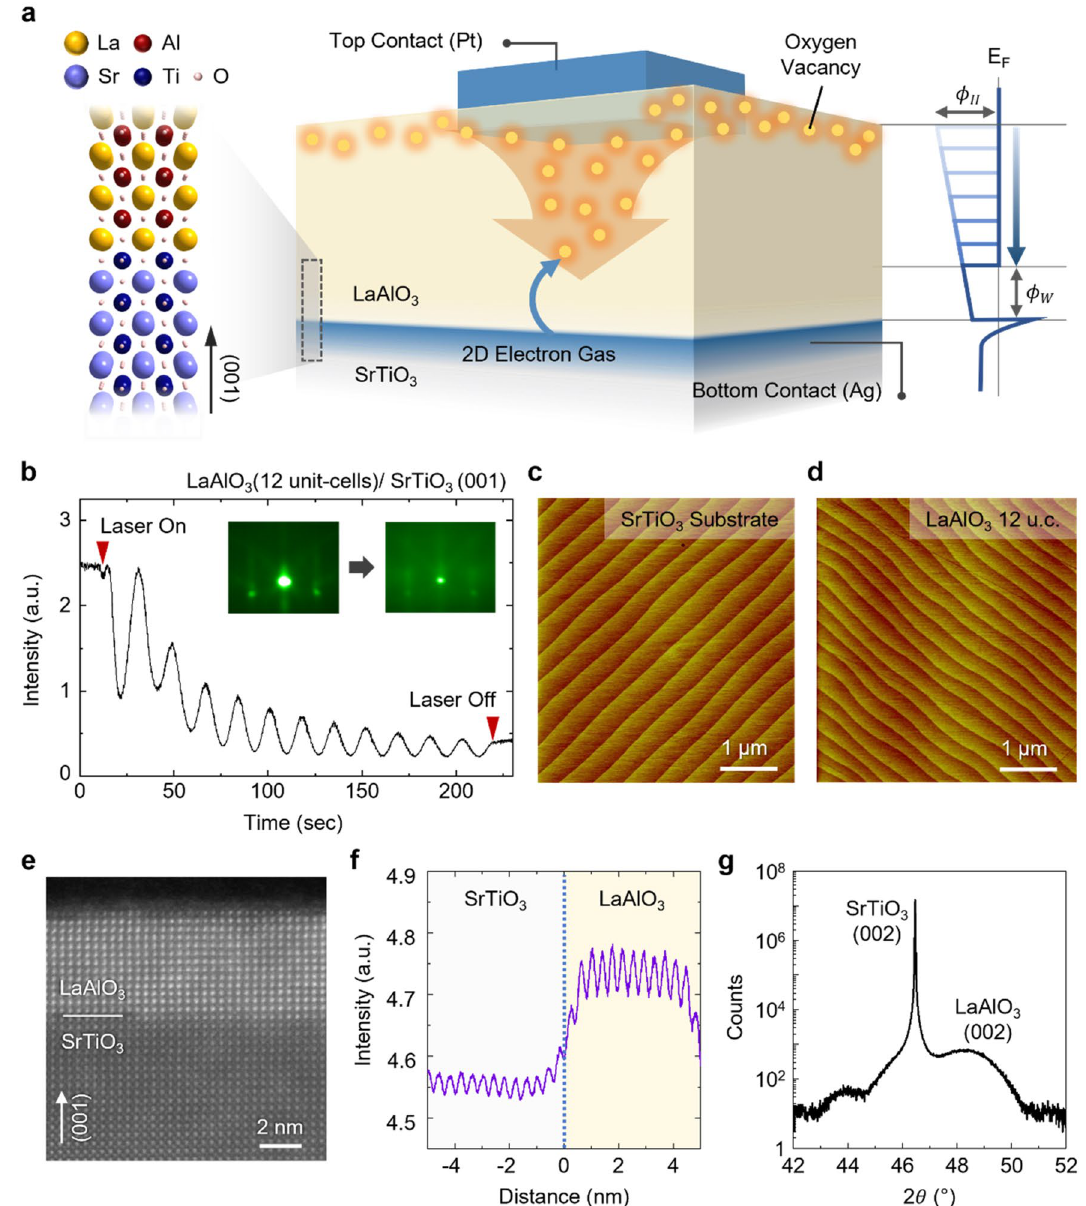
Figure 1. Resistive switching device based on a Pt/LAO/STO heterostructure. ( a ) Schematic depicting the mechanism for the resistive switching in the oxide heterostructure. The spatial distribution of oxygen vacancies determines the tunneling probability of the 2DEG between the LAO/STO interface and the top Pt electrode. ( b ) Thickness-dependent evolution of the in situ RHEED intensity oscillation during the PLD deposition of LAO thin films. The insets show the RHEED patterns before and after the film growth. ( c ) AFM topography image measured on the surface of a thermally-treated STO (001) substrate. ( d ) AFM topography image measured on the surface of an as-grown LAO thin film. ( e ) HAADF-STEM image of the LAO/STO heterostructure. ( f ) Intensity of a line profile along (001) obtained from the STEM image. ( g ) XRD θ –2 θ scan of the LAO/STO